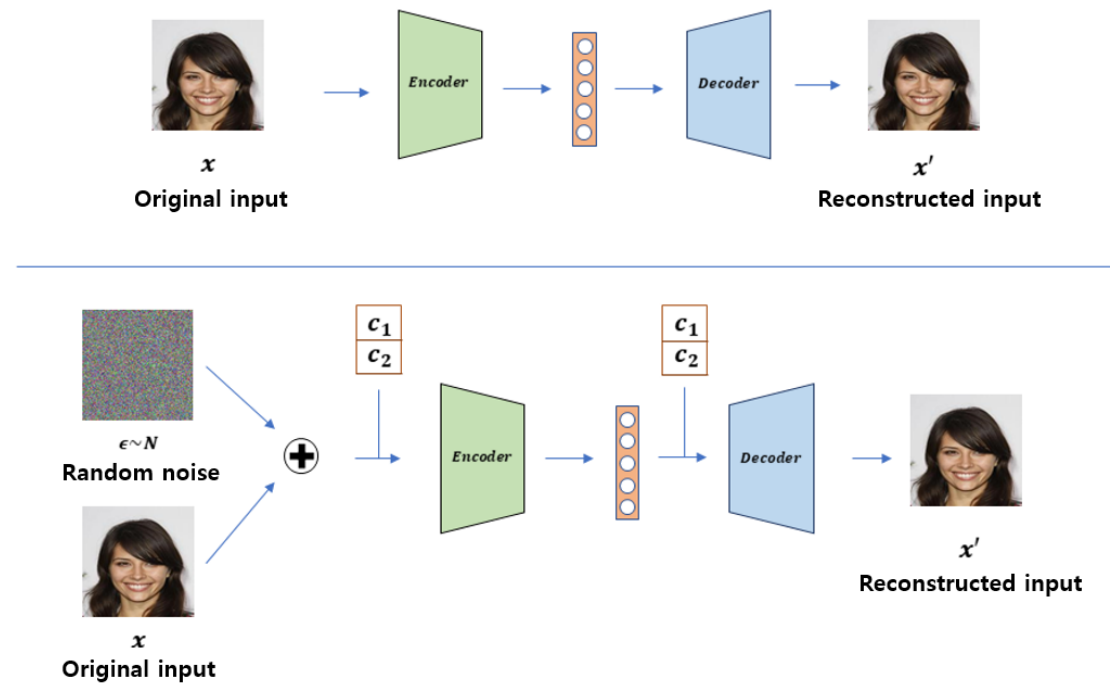
Figure 1. Conceptual comparison between balanced generative adversarial network (BAGAN) autoencoder and the proposed generative adversarial network for class-conditional data augmentation (GANDA) autoencoder. Random noises are inserted into an input image to diversify output images. The conditional one-hot code is inserted into the proposed encoder and decoder to generate definite